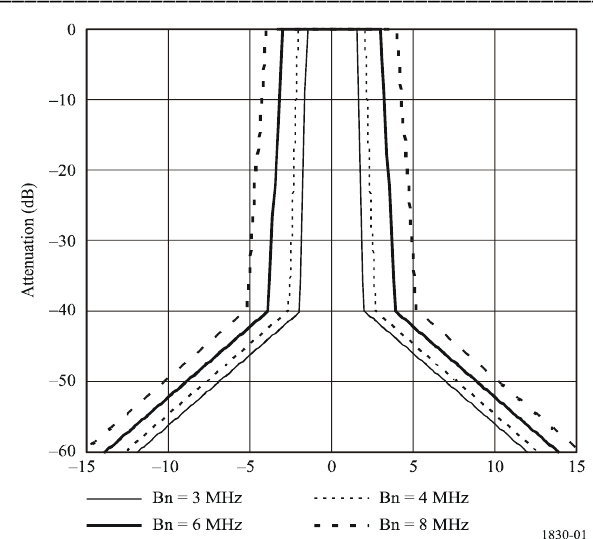
Fig. 6. Perspective ARNS receiver filter mask for the 645 MHz – 862 MHz band